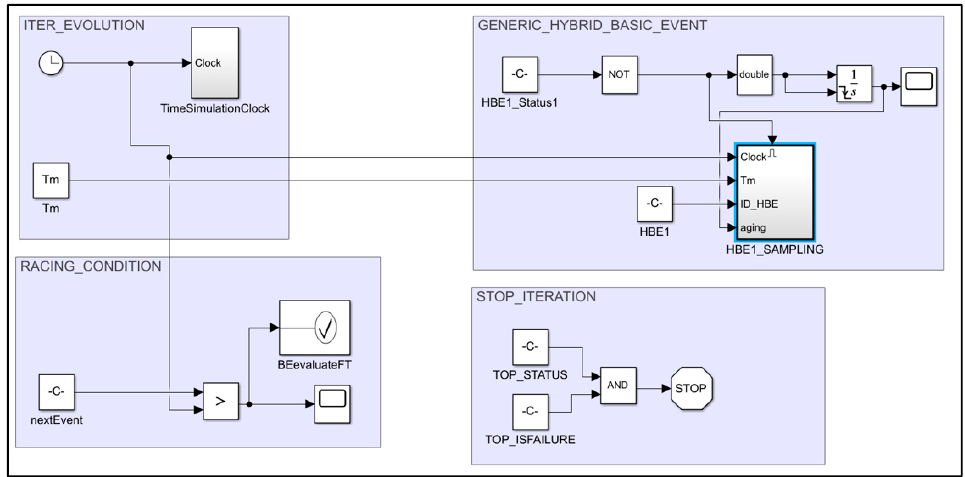
Figure 3. SHyFTA_TEMPLATE.slx file of the SHyFTOO library package.